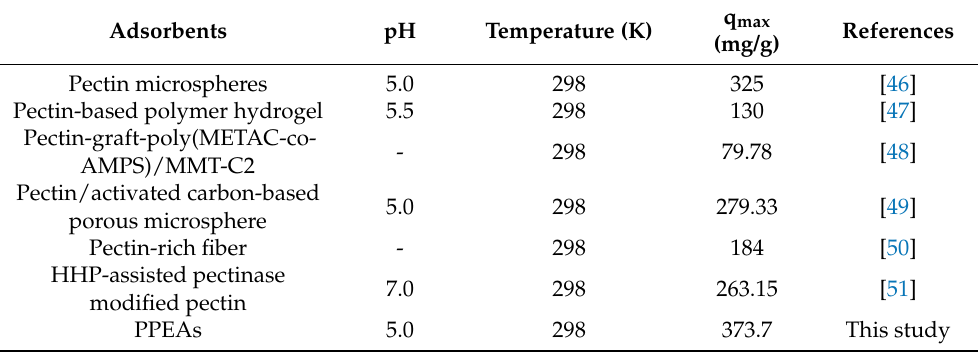
METAC: 2-(methacryloyloxyethyl) trimethylammonium chloride, AMPS: 2-acrylamido-2-methyl-1-propane sulfonic acid, MMT: composite with montmorillonite, HHP: high hydrostatic pressure. A hyphen in the